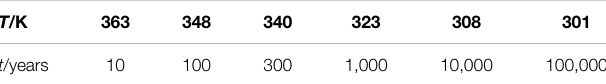
TABLE 1 | Predicted temperature corresponding to disposal time.